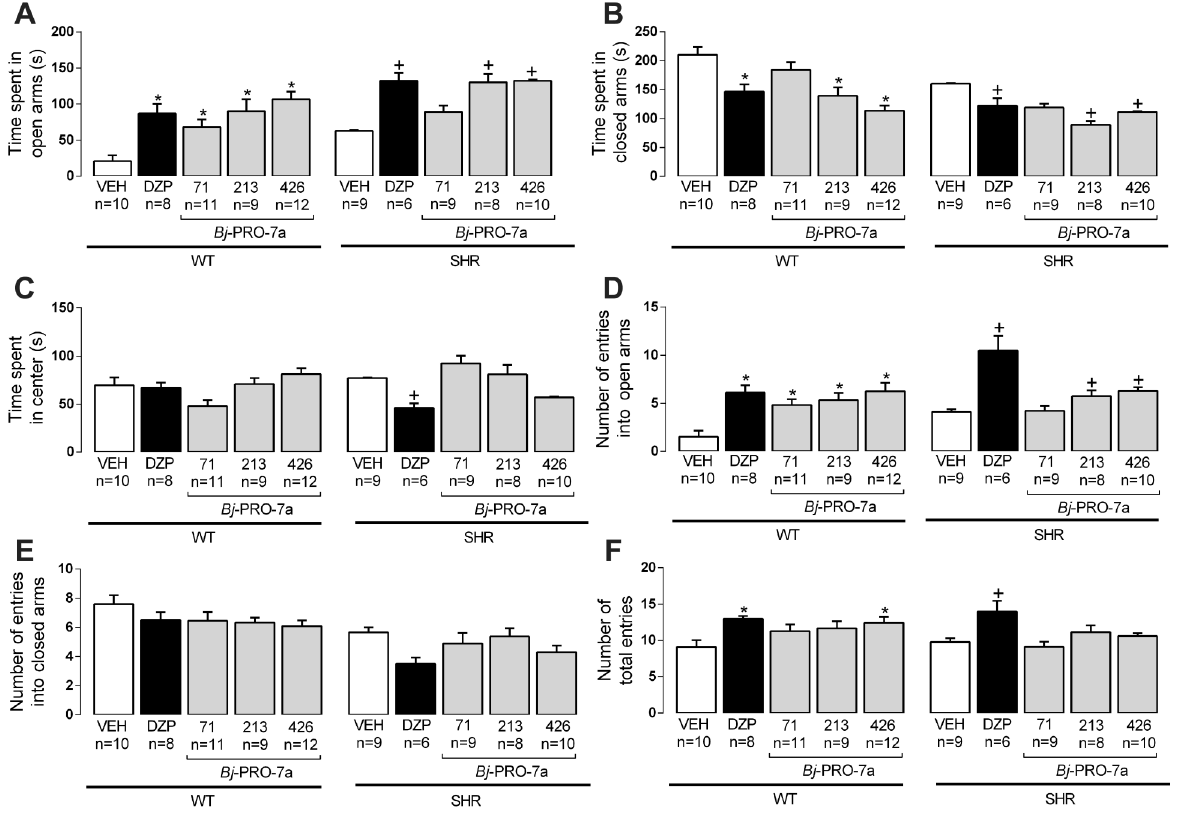
Figure 1. Effects of Bj-PRO-7a on anxiety-like behaviors in the elevated plus maze in Wistar (WT) and spontaneously hypertensive rats (SHRs). A , Time spent in open arms; B , Time spent in closed arms; C , Time spent in center; D , Number of entries into open arms; E , Number of entries into closed arms; F , Number of total entries. Experimental groups: VEH: vehicle (0.9% NaCl); DZP: diazepam (2 mg/kg); Bj-PRO-7a (71, 213, or 426 nmol/kg). Data are reported as means ± SE. *P o 0.05 vs VEH WT; + P o 0.05 vs VEH SHR (two-way analysis of variance followed by Bonferroni ’ s post hoc